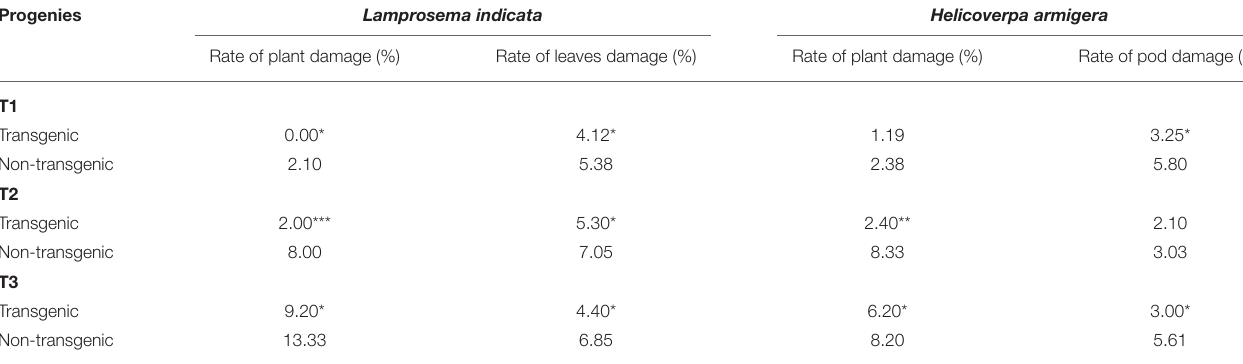
TABLE 4 | Main insect effect of VX93 transgenic lines from T1 to T3 generations under field condition. Progenies Lamprosema